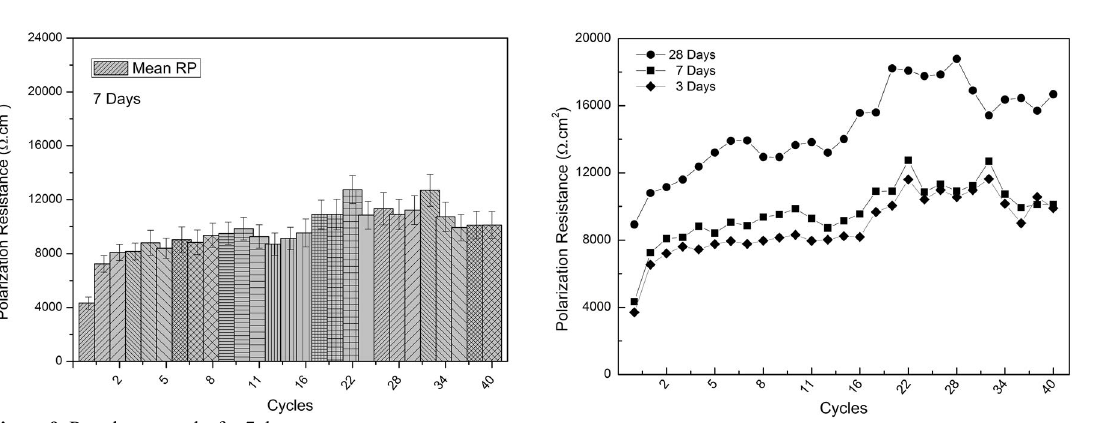
Figure 11. Comparative plots of R